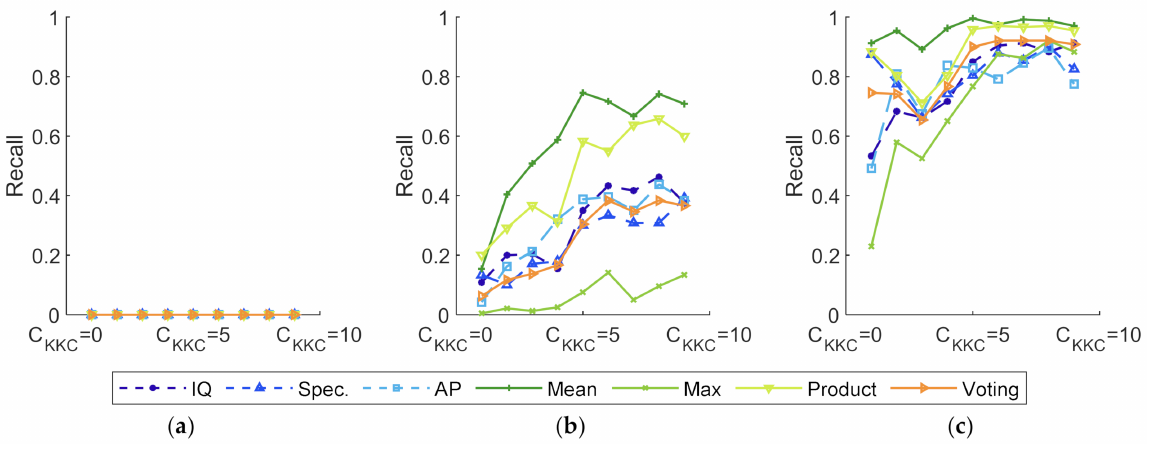
Figure 15. Recall of experiments with various C KKC and classifiers. ( a ) Softmax as basic classifiers; ( b ) softmax-threshold as basic classifiers; ( c ) OpenMax as basic classifiers.